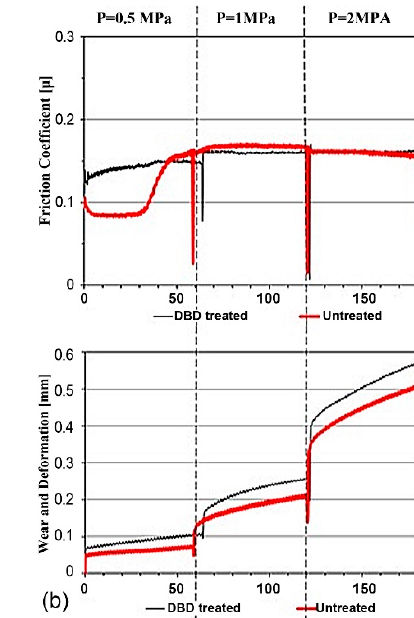
Figure 7. Coefficient of friction and wear loss for ( a ) PA66 and ( b ) PTFE.